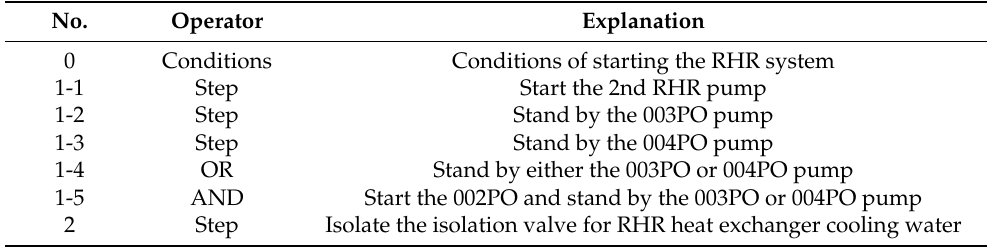
Figure 5. An example of modeling operating procedures with MSM at procedure level. Table 2. Operator explanation of the MSM model in Figure 2.